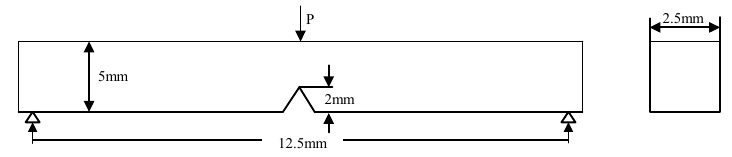
Figure 2. Three-point bending test schematic diagram.